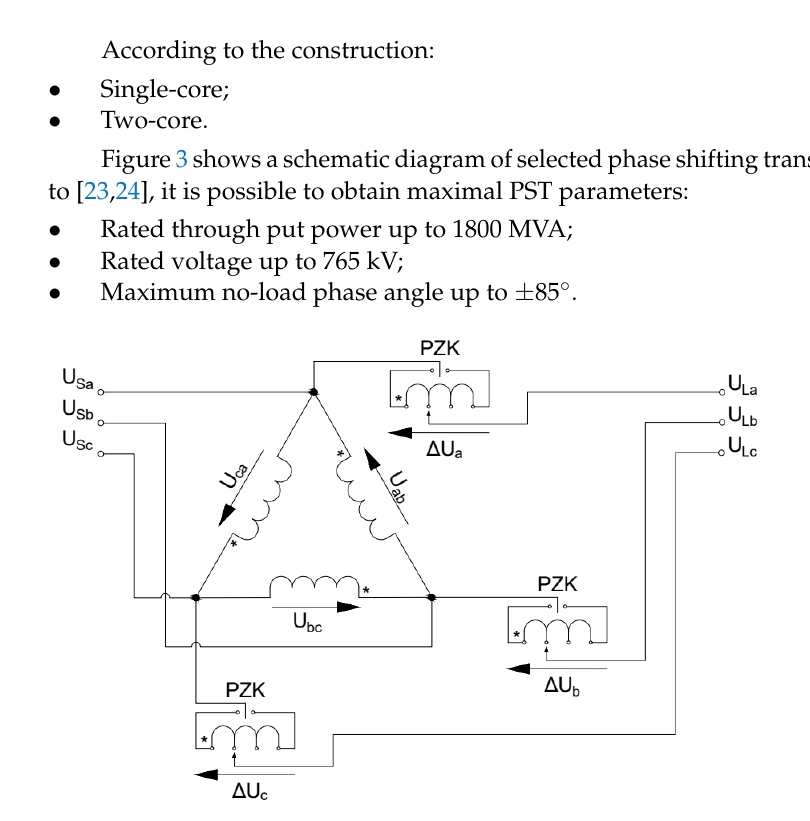
Figure 3. Asymmetrical single core PST scheme.